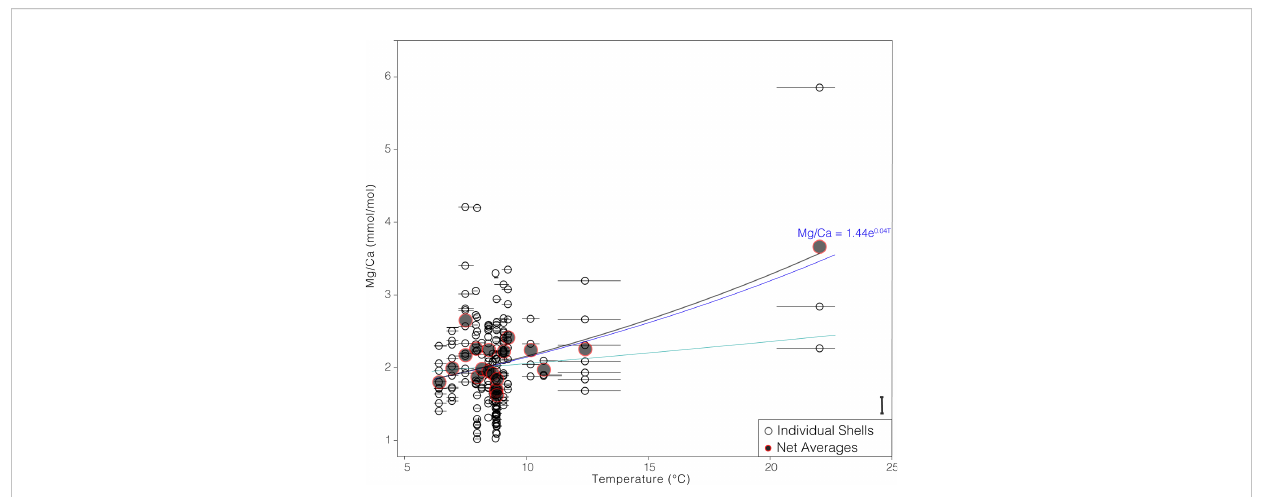
FIGURE 2 Mg/Ca values of individual shells (open black points), and net means (closed gray/red points) relative to in situ temperature at collection. Points are plotted against the mean temperature from the net in which the foraminifers were collected, and horizontal bars show the minimum to maximum temperature measured in that net. Exponential fi t based on individual shell data is shown as a bright blue line, and in black for net means; exponential fi t exclusive of the highest temperature is shown in turquise. The mean difference between duplicate ablations of the same chamber is show as a bar in the bottom